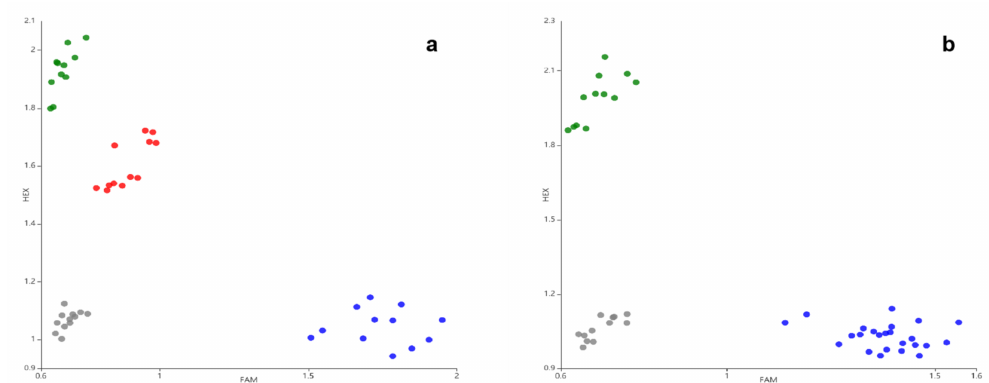
Figure 2. Genotyping of different rapeseed materials using the PARMS markers. ( a ) Fluorescence im- age amplified by MS5-1Fc/MS5-1Ft/MS5-1R12. The green, red and blue dots are the individuals with BnMS5 a BnMS5 a , BnMS5 c BnMS5 e and BnMS5 c BnMS5 c genotype, respectively. ( b ) Fluorescence image amplified by MS5-2Ft/MS5-2Fa/MS5-1R12. The green dots are the individuals with BnMS5 a BnMS5 a genotype. The blue dots are the individuals with BnMS5 c BnMS5 c and BnMS5 c BnMS5 e genotype. The gray dots are negative